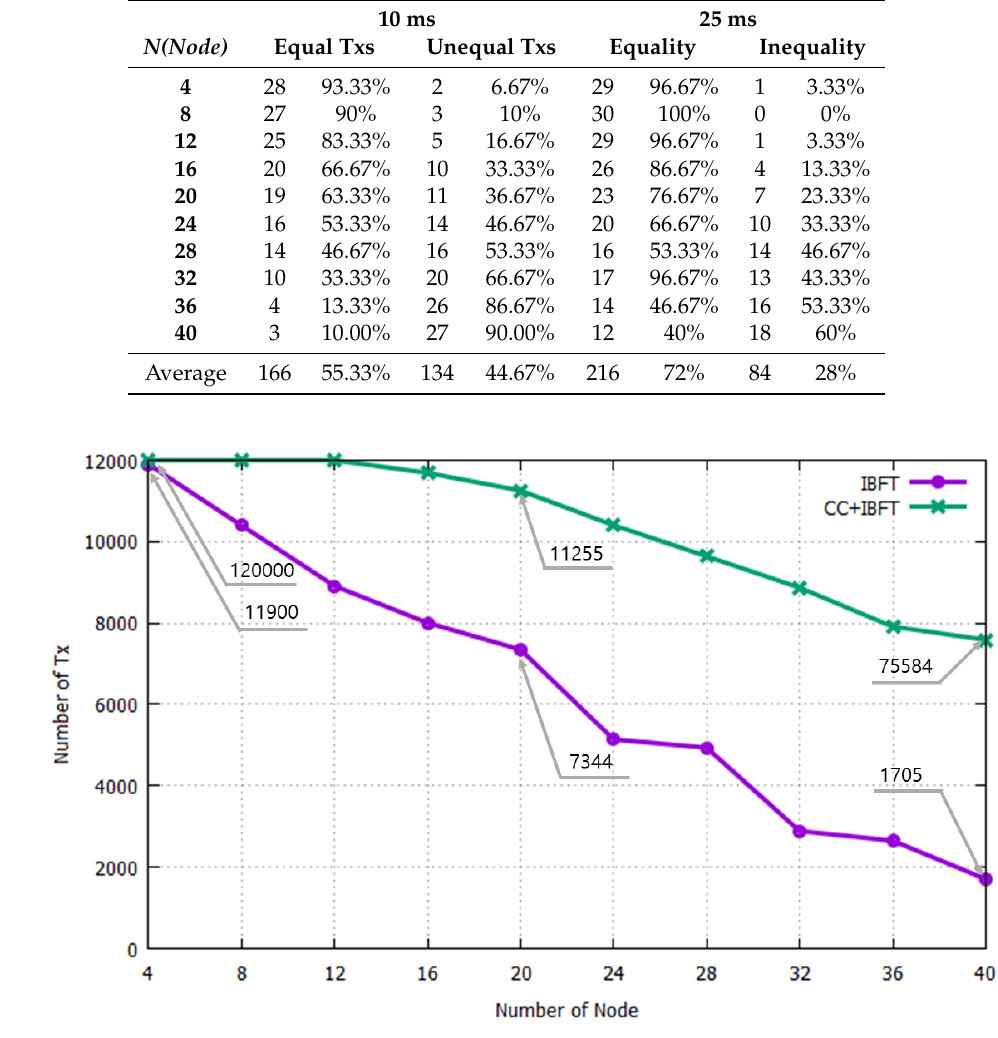
Table 2. Result of monitoring equal and unequal transactions of consensus coordinator.